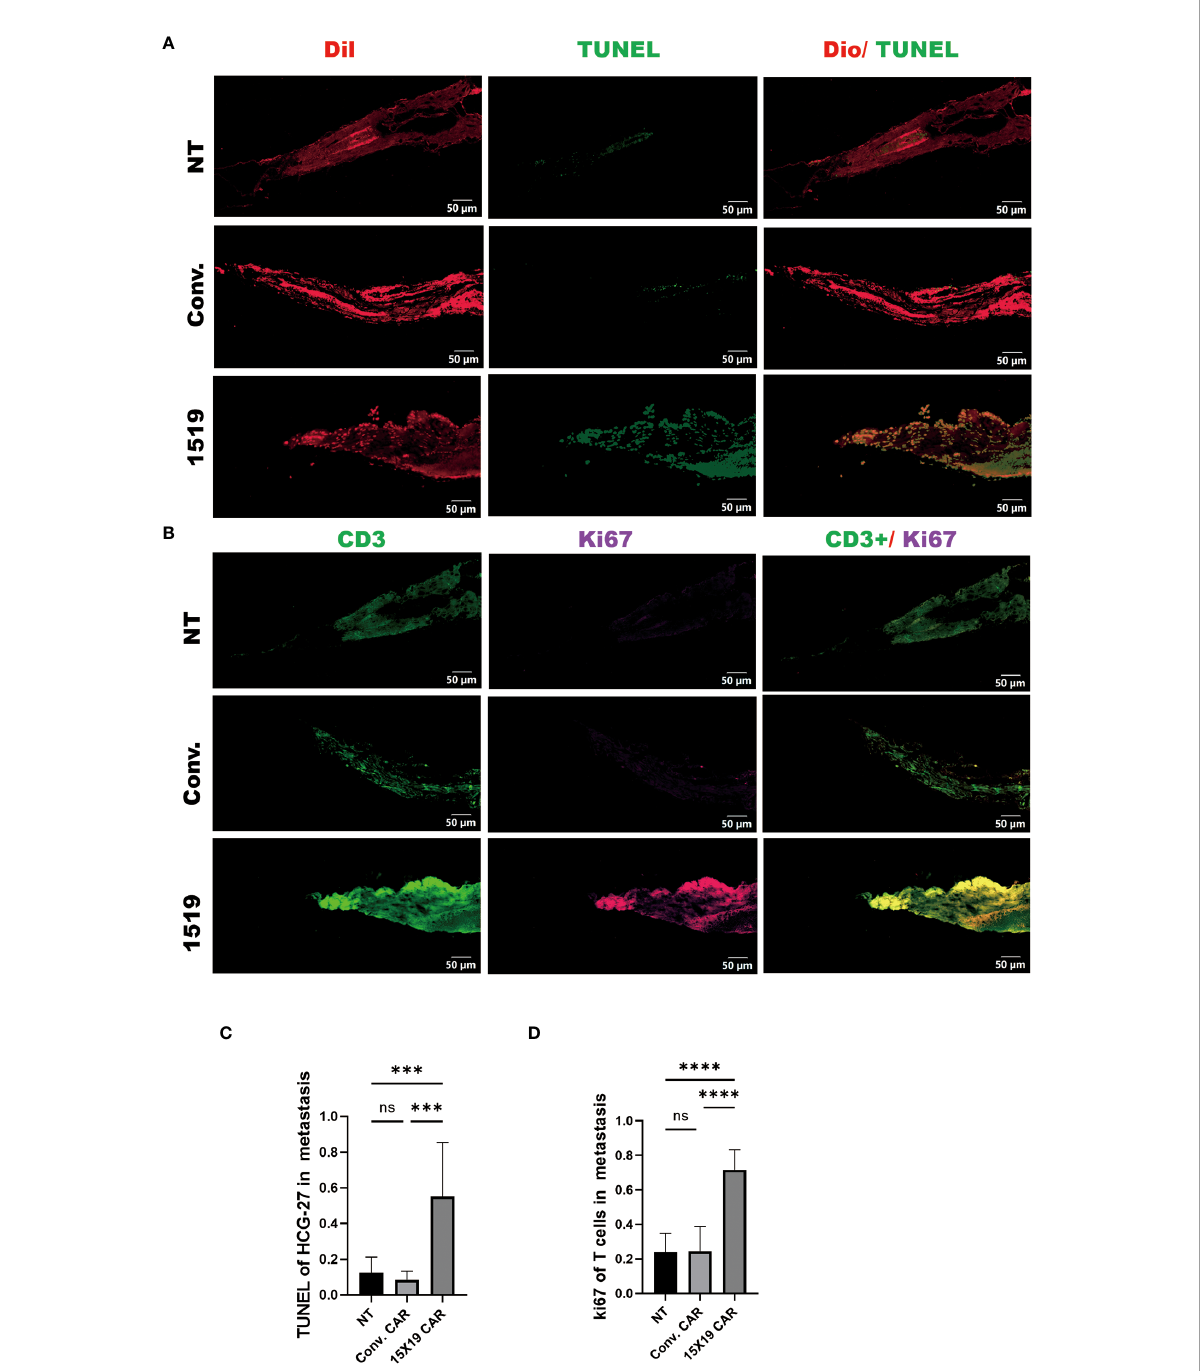
FIGURE 10 Proliferation of transplanted T cells and tumor apoptosis in zebra fi sh metastases. Immuno fl uorescence of TUNEL and ki-67 were performed on transplanted tumor cells and T cells separately. (A) , Representative images of tumor apoptosis (TUNEL : DIO); (B) , representative images of proliferating T cells (Ki-67:CD3). (C) , Proportion of TUNEL-positive cells in HCG-27 cells; (D) , Proportion of Ki-67-positive cells in T cells. Statistical signi fi cance analysis was performed using one-way ANOVA and multiple comparison test. ns, Differences are not signi fi cant; ***p < 0.001; ****p < 0.0001, scale bar = 50 m